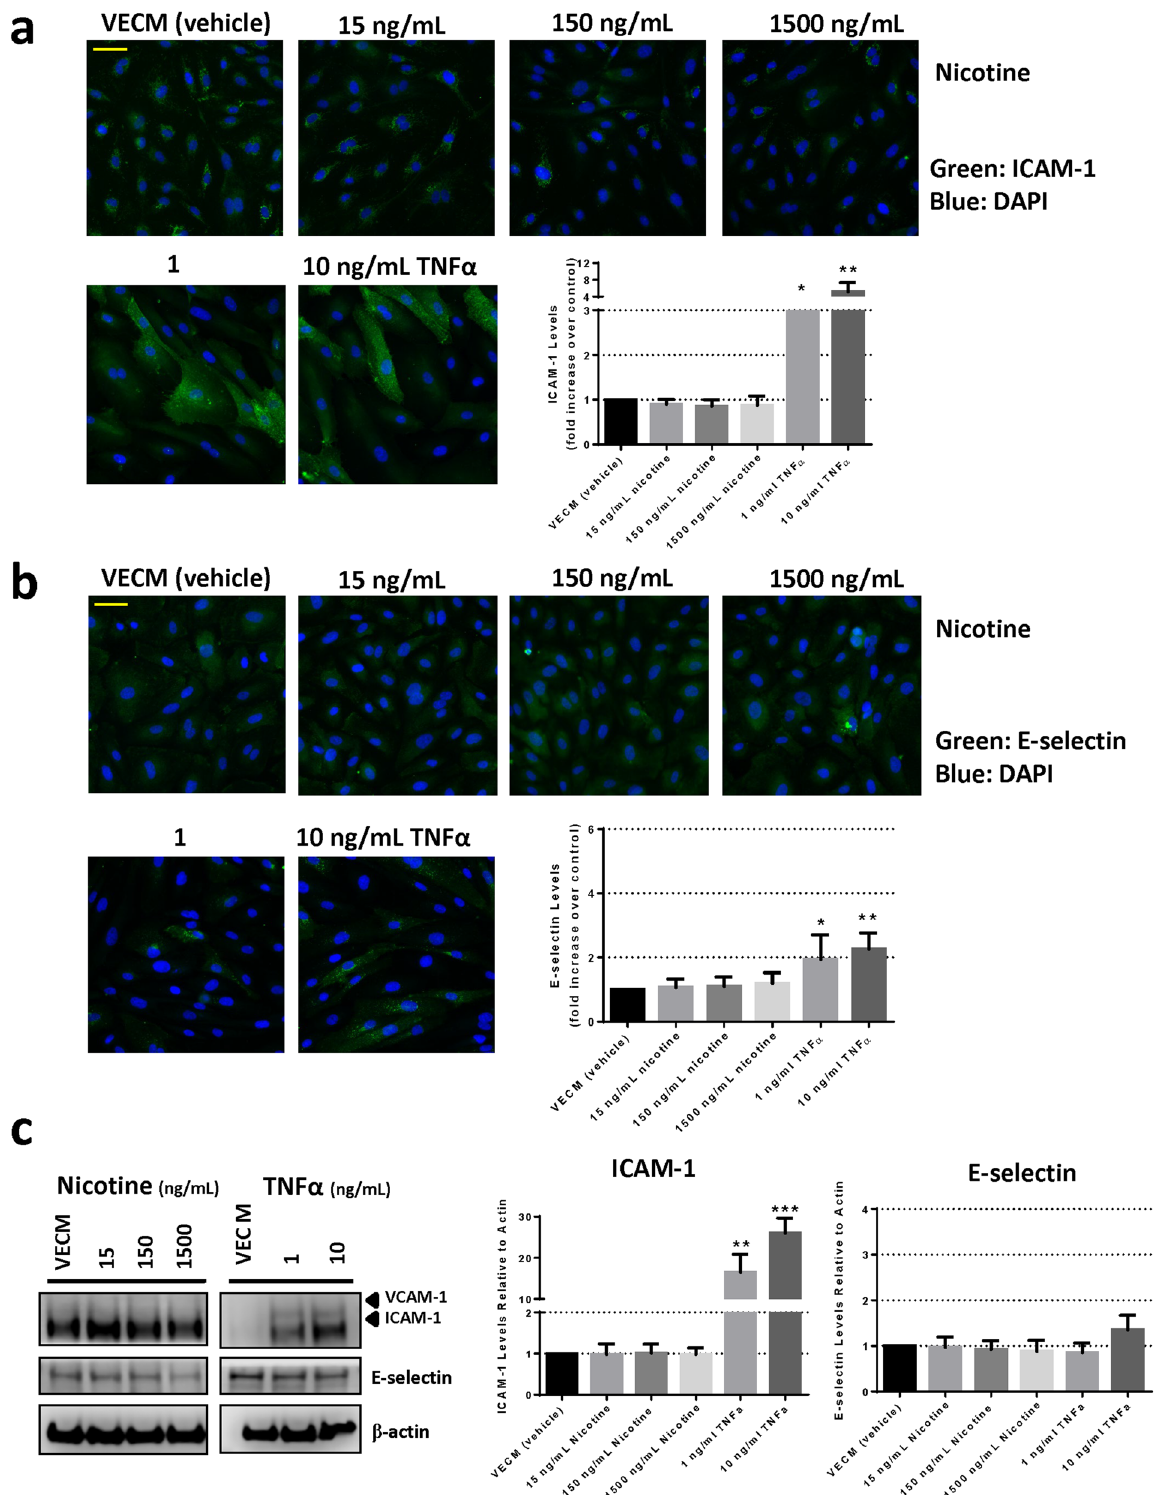
Figure 5. Analysis of ICAM-1 and E-selectin expression in HAECs following 24 h exposure to nicotine. ( a ) Immunofluorescence microscopy analysis and associated quantification of ICAM-1 or ( b ) E-selectin expression following HAEC exposure to nicotine for 24 h in Ibidi chamber slides. Images were captured using a Zeiss Axio Observer.Z1 microscope (×20 magnification). Scale bar (yellow line) = 70 µm. Errors bars denote ± SD (n = 6). ( c ) Western blot analysis and associated quantification of ICAM-1, VCAM-1 and E-selectin expression in HAECs following 24 h exposure to nicotine (refer to Supplementary Figure S1 for uncropped blots). One-way ANOVA with Dunnett’s multiple comparisons between vehicle control and each nicotine concentration. Error bars denote ± SD (n = 3); *p < 0.05 **p < 0.01 ***p <